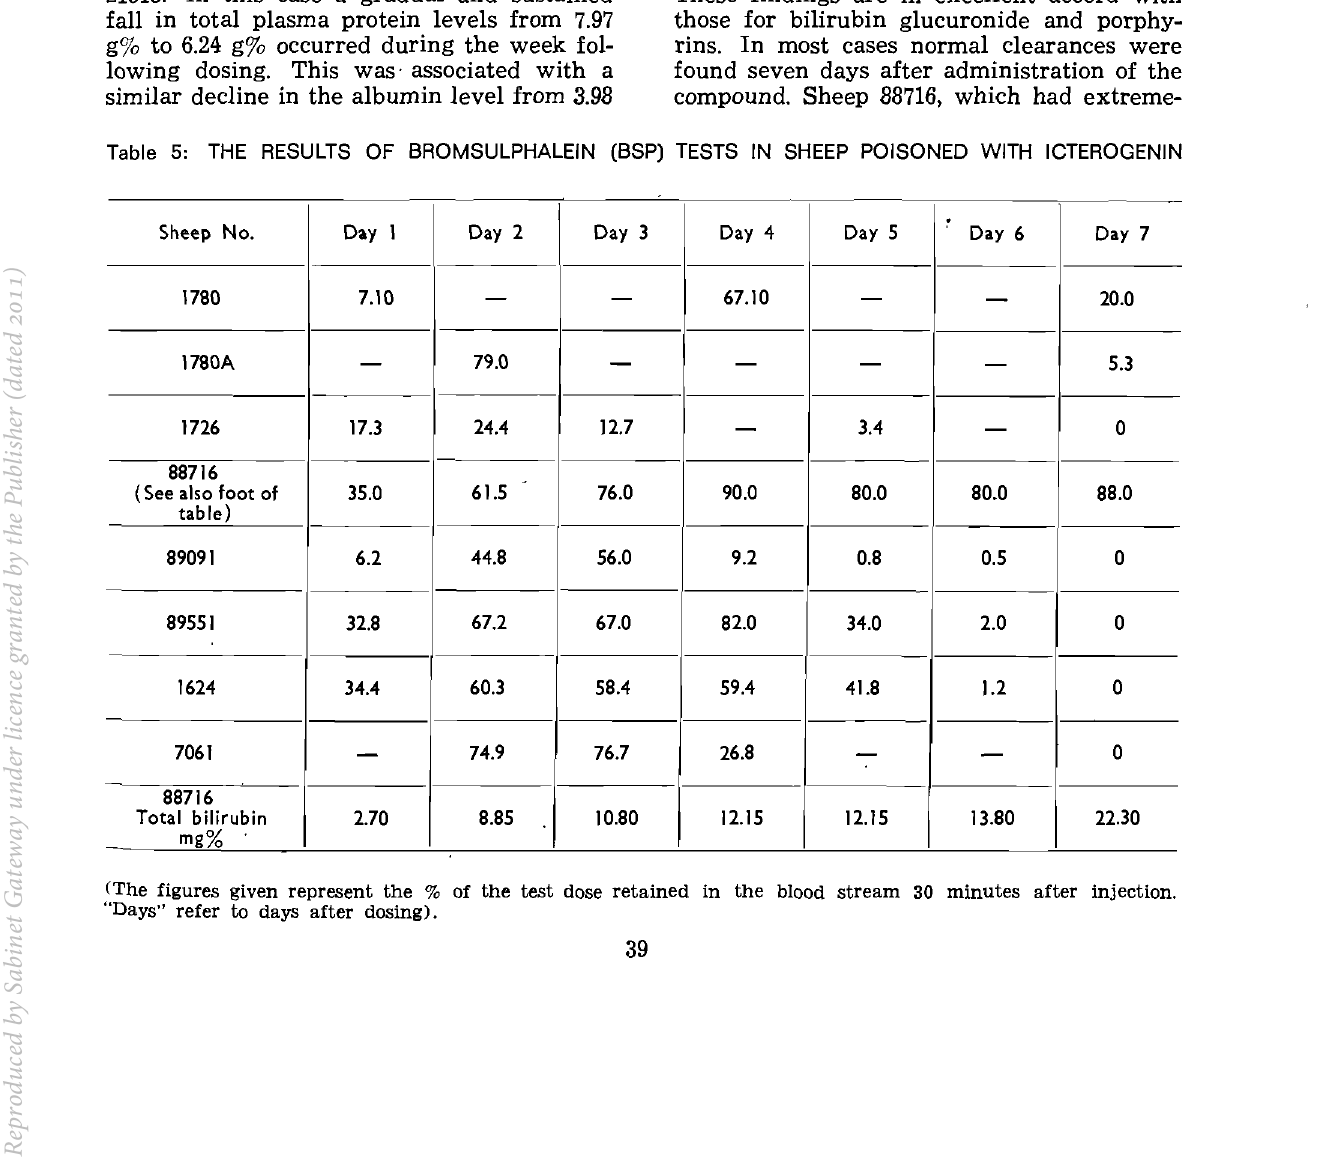
Table 5: THE RESULTS OF BROMSULPHALEIN (BSP) TESTS IN SHEEP POISONED WITH ICTEROGENIN